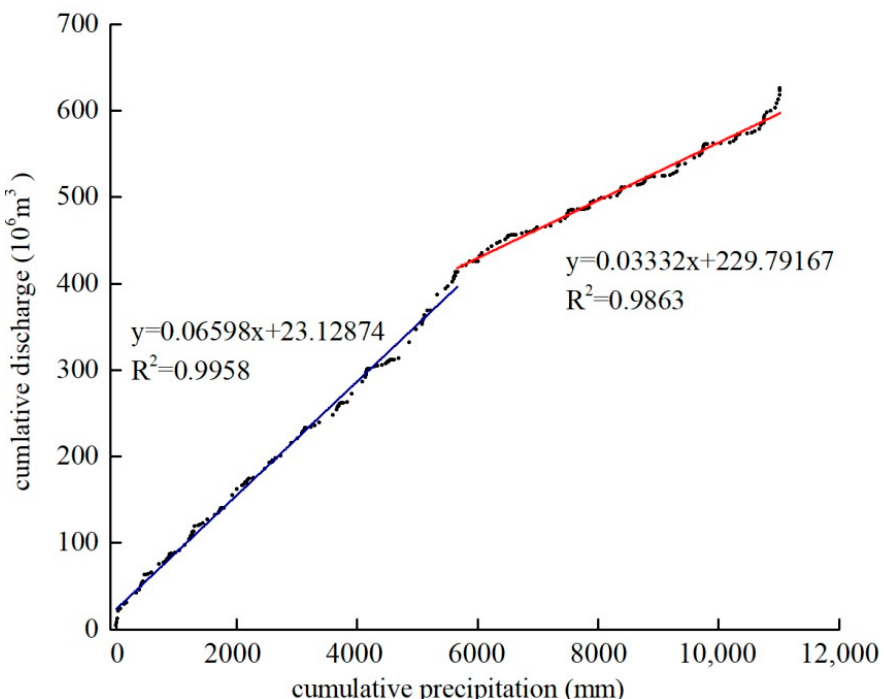
Figure 2. The double mass curve for period 1980–2016 in Chongli station.